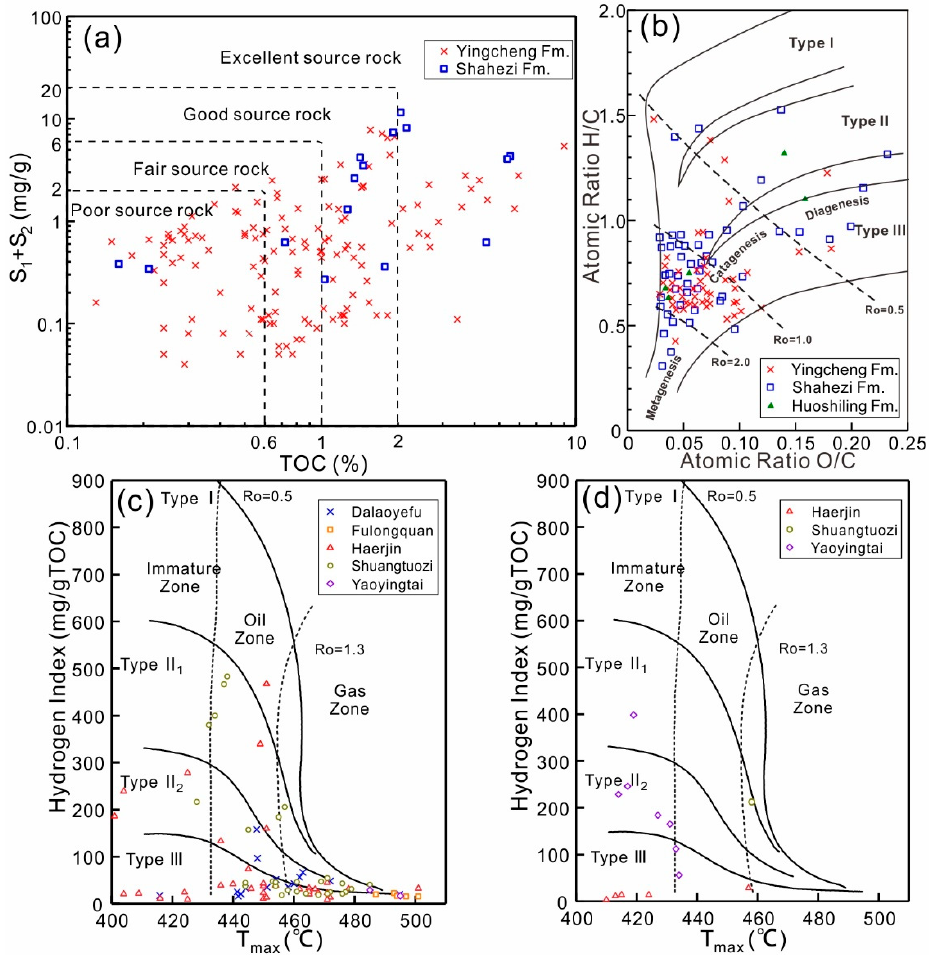
Figure 4. Source rock evaluation plots of the main source rocks in the deep Changling Depression. ( a ) Variation in Rock–Eval S 1 + S 2 with the total organic carbon content (TOC). ( b ) Kerogen type and maturation definition with a van Krevelen diagram. ( c ) Hydrogen index (HI) with pyrolysis peak temperature (Tmax) for samples from K 1 y. ( d ) HI with Tmax for samples from K 1 sh.